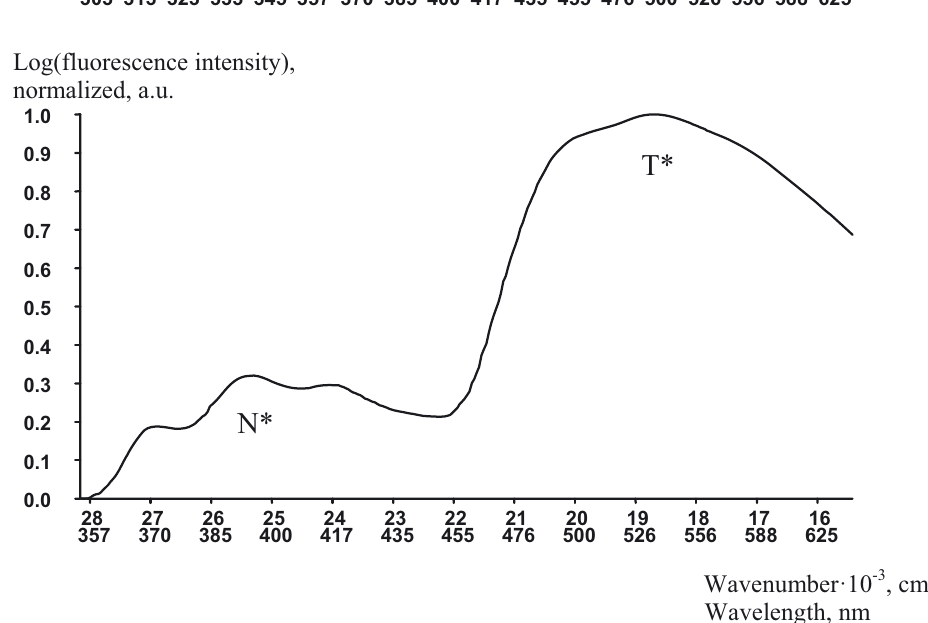
Figure 2. Upper: absorption and fluorescence spectra of 2a in toluene. The short-wavelength emission band of the normal form (dotted line) is shown normalized to the long-wavelength absorption maximum. Lower: emission spectrum of 2a in semi-logarithmic